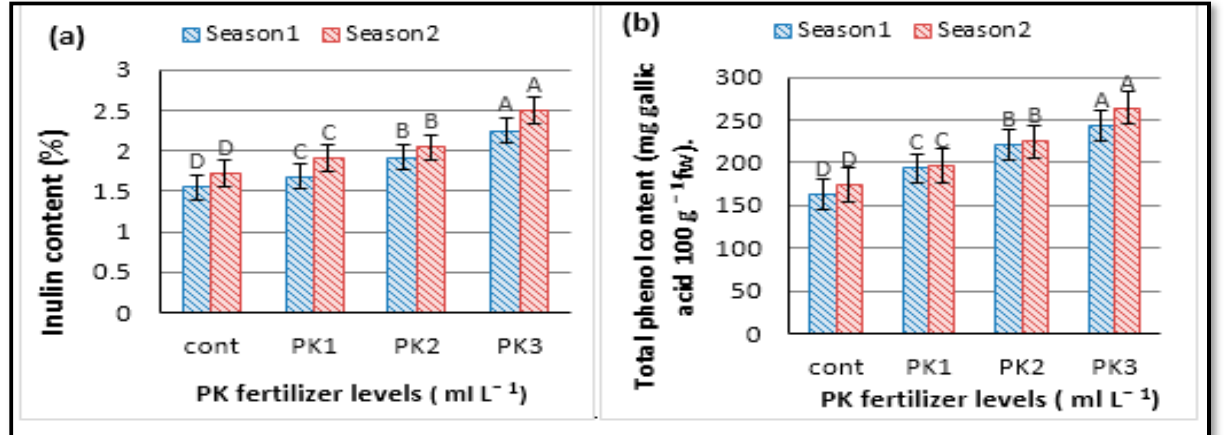
Figure 7. Head quality (mean ± SE) of globe artichoke as affected by the PK fertilizer levels (Control: without, PK 1 : 25, PK 2 : 50 and PK 3 : 75 mL L − 1 ) on ( a ) Inulin content (%) and ( b ) Total phenols content ( mg gallic acid 100 g − 1 fw). Letters in the figures indicate that the mean ± SE treatments with the same letters were not significantly different according to Duncan’s multiple range test for p < 0.05.